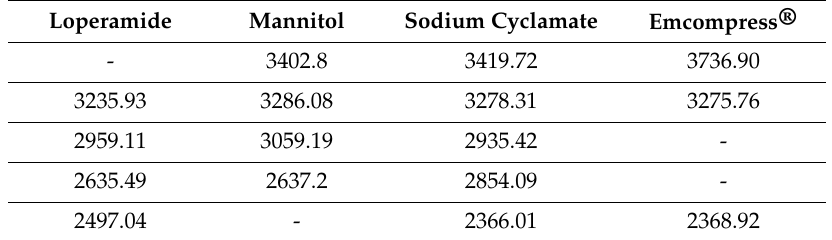
Table 3. Peaks (cm − 1 ) of loperamideHCl, mannitol, sodium cyclamate and Emcompress ®